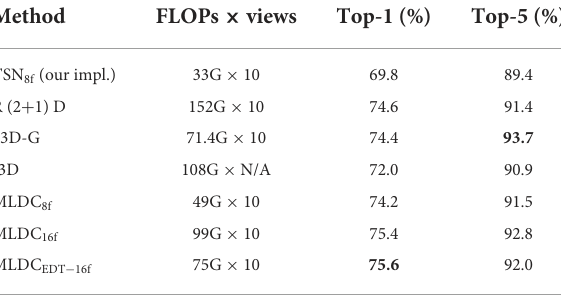
TABLE 4 Experimental results of embedding MLDC modules at different locations of ResNet network.